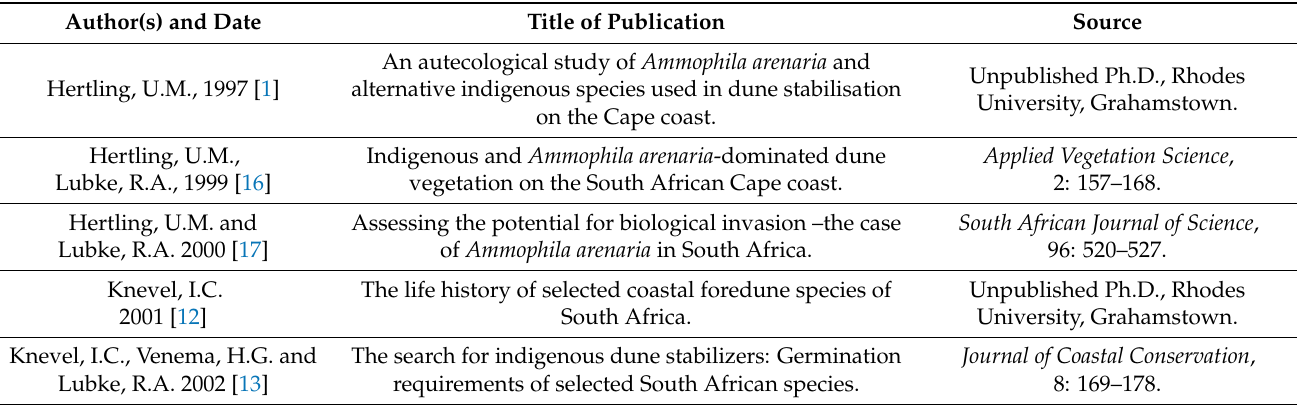
Table 2. List of publications on Ammophila arenaria (marram grass) and related dune pioneers investigated as part of the Invasive Grass species study